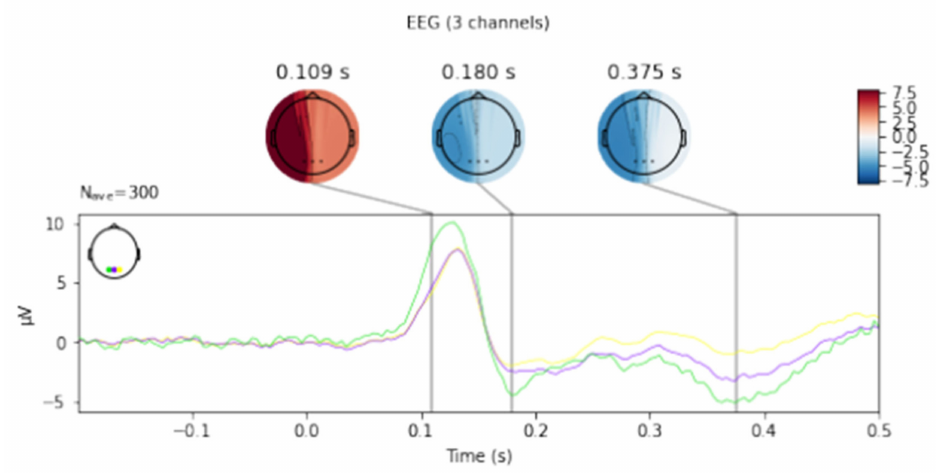
Figure 2. The averaged signal for electrodes O1 (green line), Oz (purple line) and O2 (yellow line).